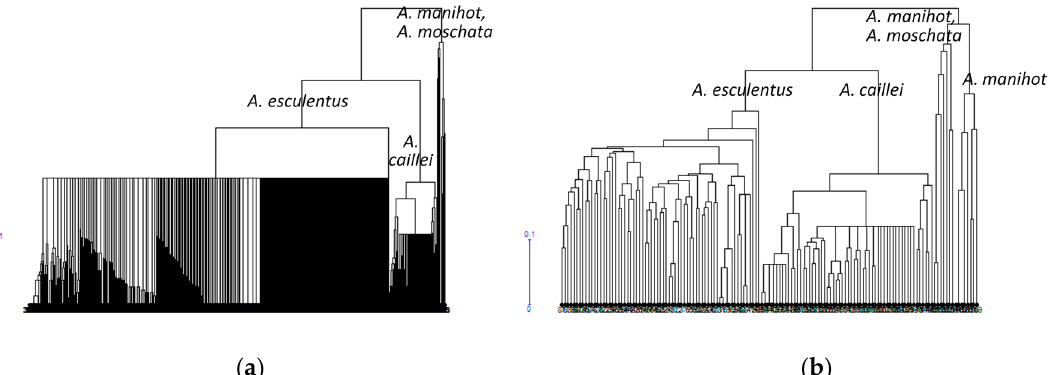
Figure 1. ( a ) Phylogenetic tree of the WorldVeg Abelmoschus collection and ( b ) of the WorldVeg Abelmoschus core collection constructed based on 20 microsatellite markers. The species contained in each clade are indicated.